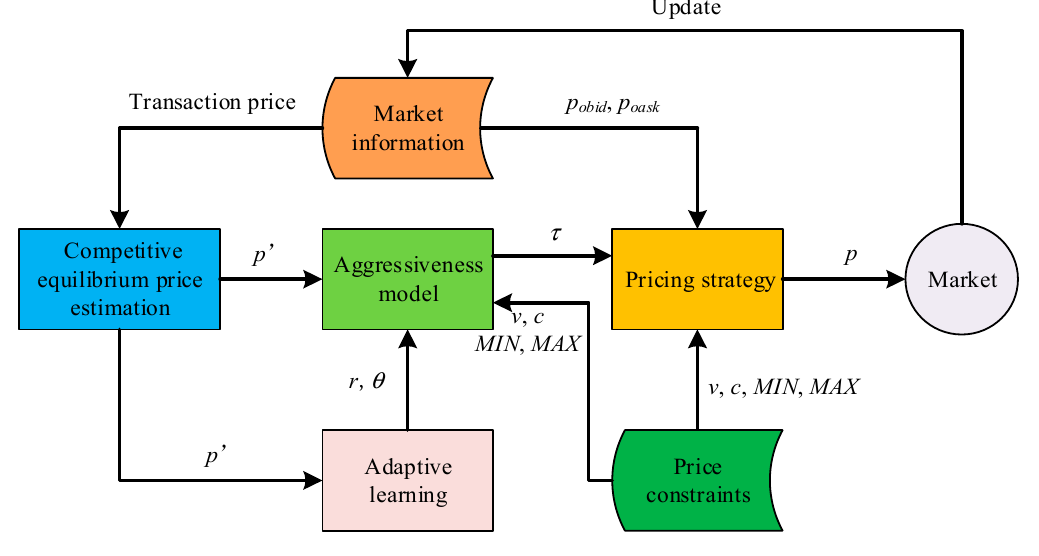
Figure 5. Schematic of AA strategy.